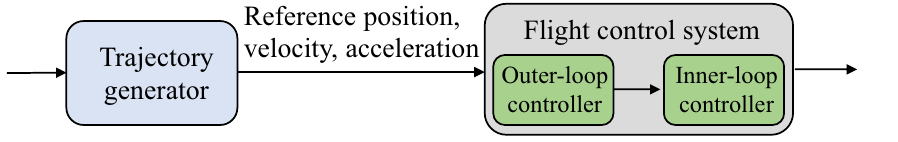
Figure 10. Hierarchical framework for trajectory